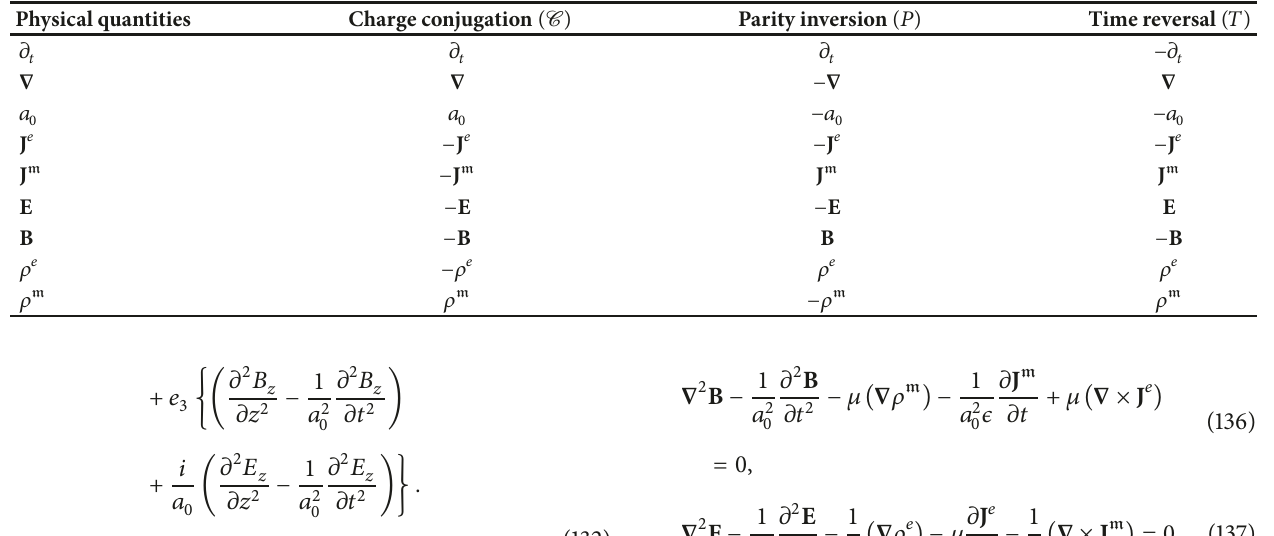
Table 2: Quaternionic physical quantities and their CPT